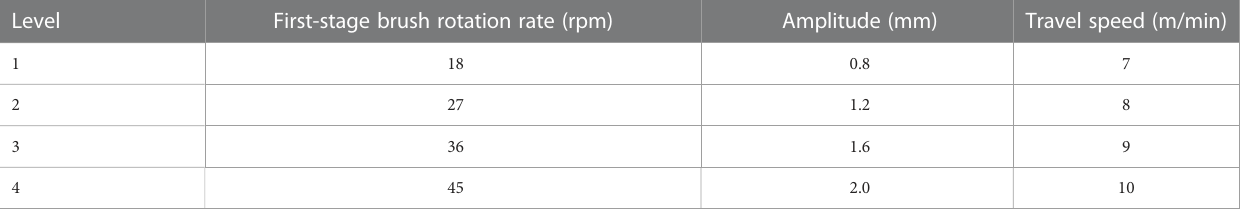
TABLE 3 Single-factor test for clam harvesting simulation.